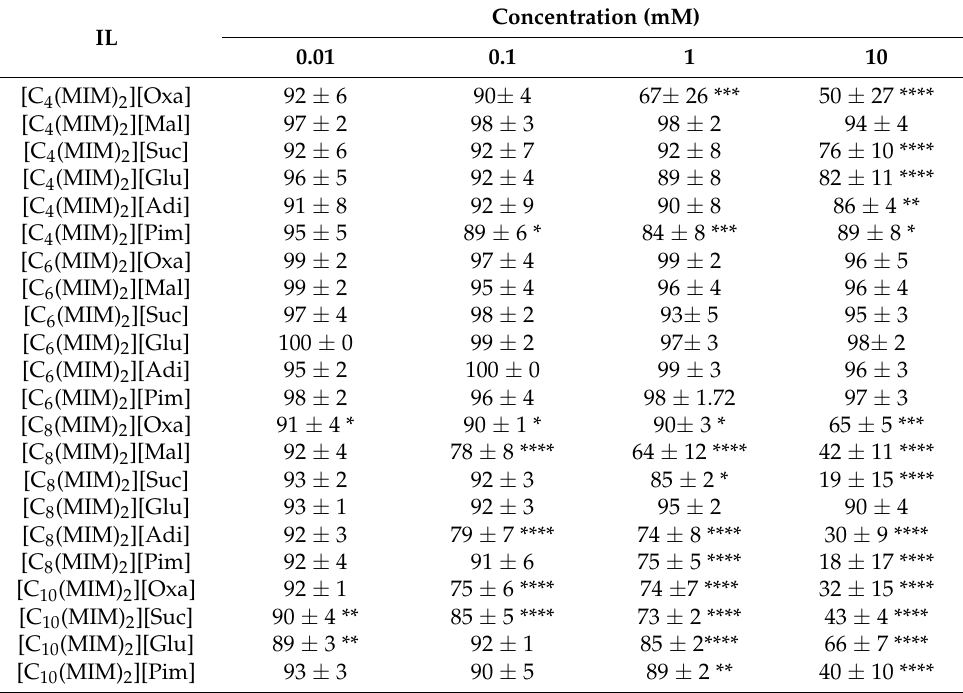
Table 6. DIL survival assay for wild-type (N2) worms (survival ± SD) a .